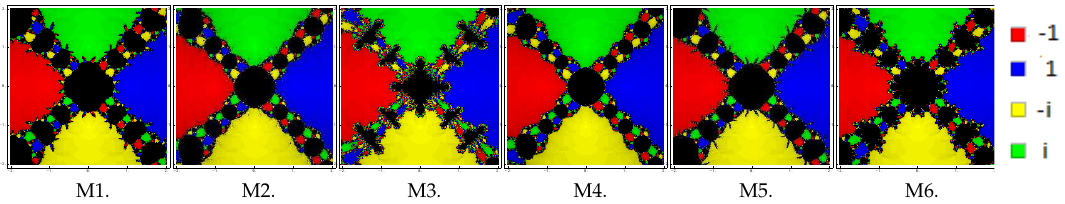
Figure 8. Basins of attraction for polynomial P 3 ( z ) for β = 10 − 4 .